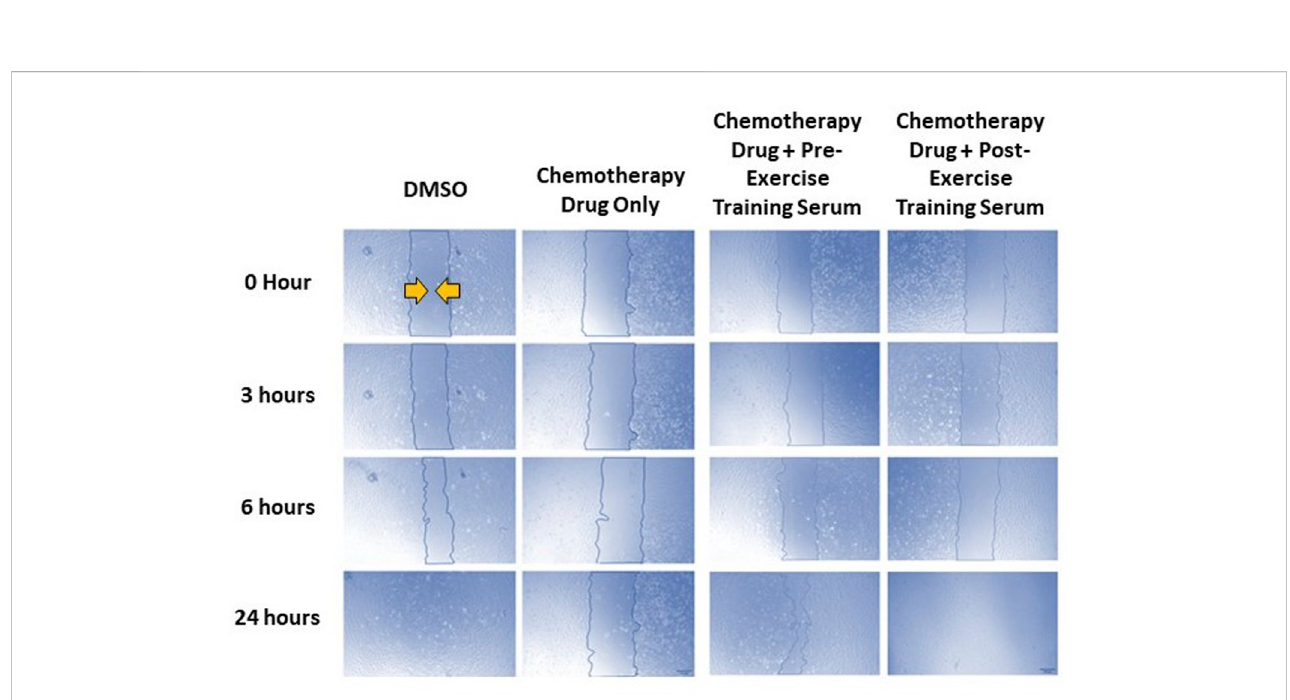
FIGURE 4 Representative images of human coronary artery endothelial cells (HCAEC) gap closure over time (0-, 3-, 6-, and 24- hours) with and without FEC drug exposure (5- fl uorouracil: 1.5 µM, epirubicin: 0.006 µM, cyclophosphamide: 38 µM), and drug exposure with pre- or post-exercise intervention serum conditioning. Images are ×4 magni fi cation. Scale bar is 250